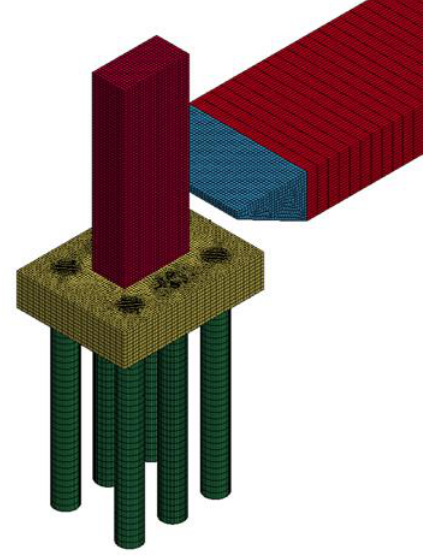
Figure 23. The barge – pier FE model.